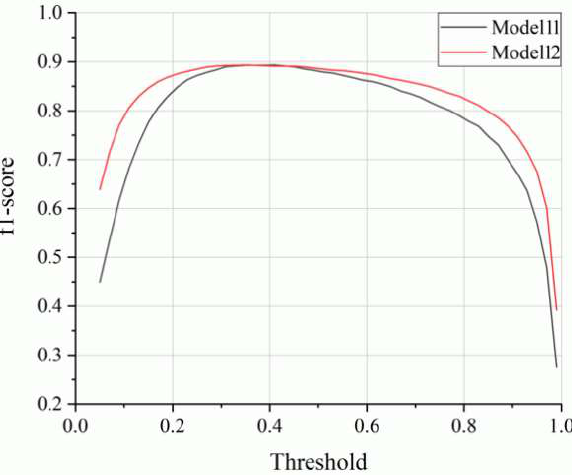
Figure 4. Changing the f1 score metric for different thresholds of model 11 and model 12. The quality metrics of the models based on the test data are given in Table 2. Table 2. Quality metrics of classifiers based on the test data. Model No